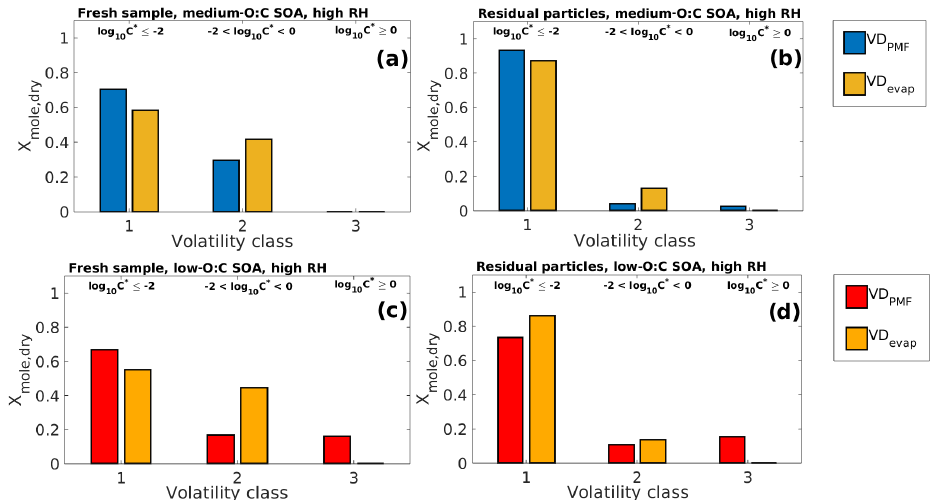
Figure 3. Comparison of VD PMF and VD evap at the mean sample evaporation time in high-RH experiments for the same four cases as shown in Fig. 1. (a) Fresh sample of medium-O : C SOA. (b) Residual particles of medium-O : C SOA (the RTC sample). (c) Fresh sample of low- O : C SOA. (d) Residual particles of low-O : C SOA (the RTC sample). The VD bins shown in Fig. 2 are grouped into three different volatility classes based on their evaporation tendency with respect to the measurement timescale and particle size. The limits for each volatility class are shown at the top and are the same for each subfigure. The VD PMF shows lower overall volatility than the VD evap , except for (d) (RTC sample of low-O : C SOA) where the VD PMF shows higher overall volatility than the VD evap .